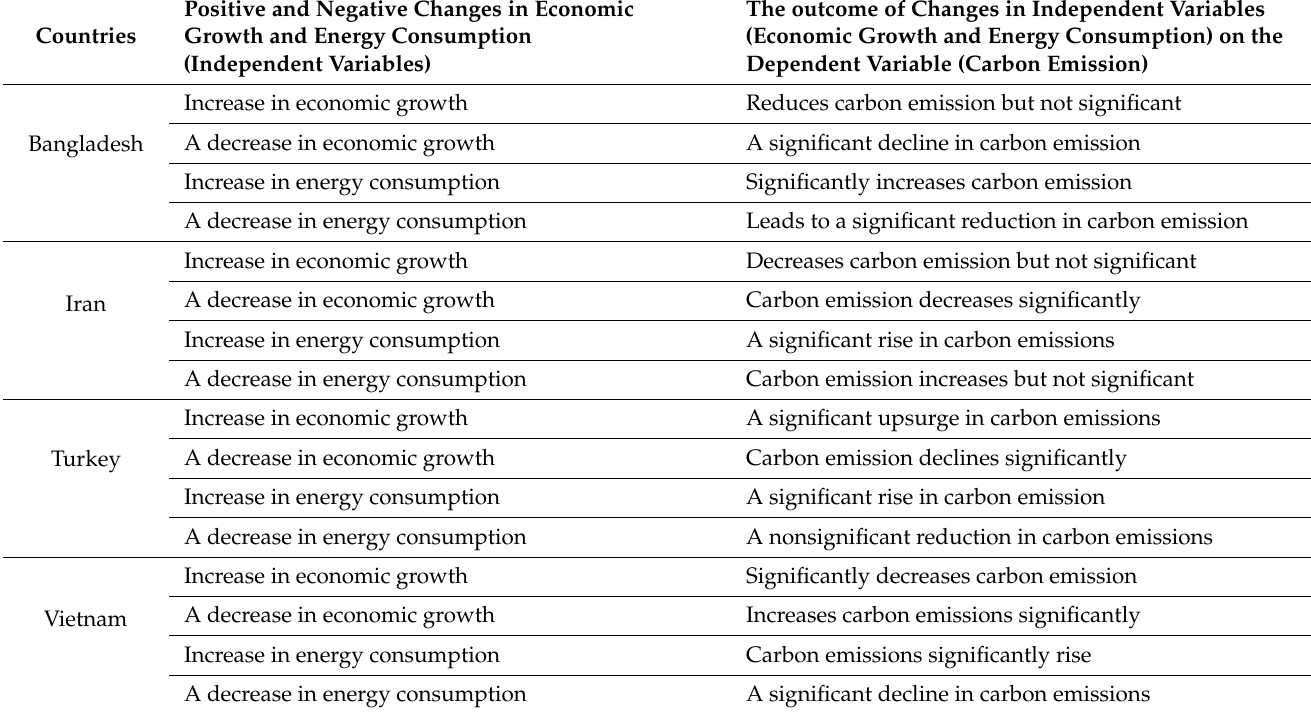
Table A1. Summary of the long-run asymmetric effects of economic growth and energy consumption on carbon emission.